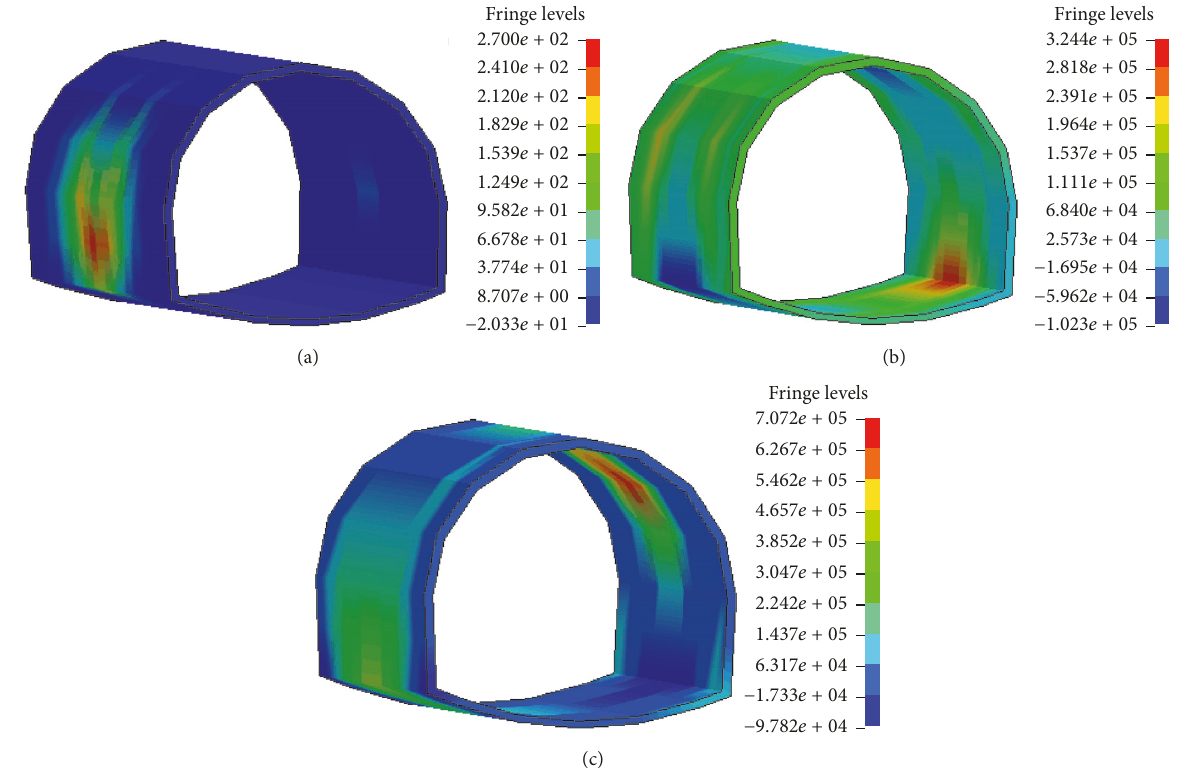
Figure 14: Maximum principle stress distribution variation induced by CD method 25 m away. ( Note . Positive value for tensile stress. (a) Time = 47.5 ms, (b) time = 91.5 ms, and (c) time = 156.5